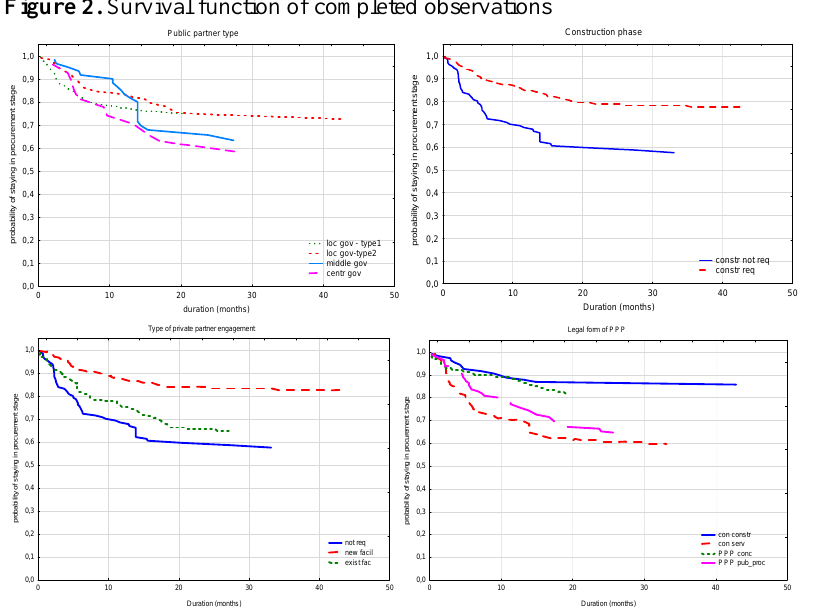
Figure 2. Survival function of completed